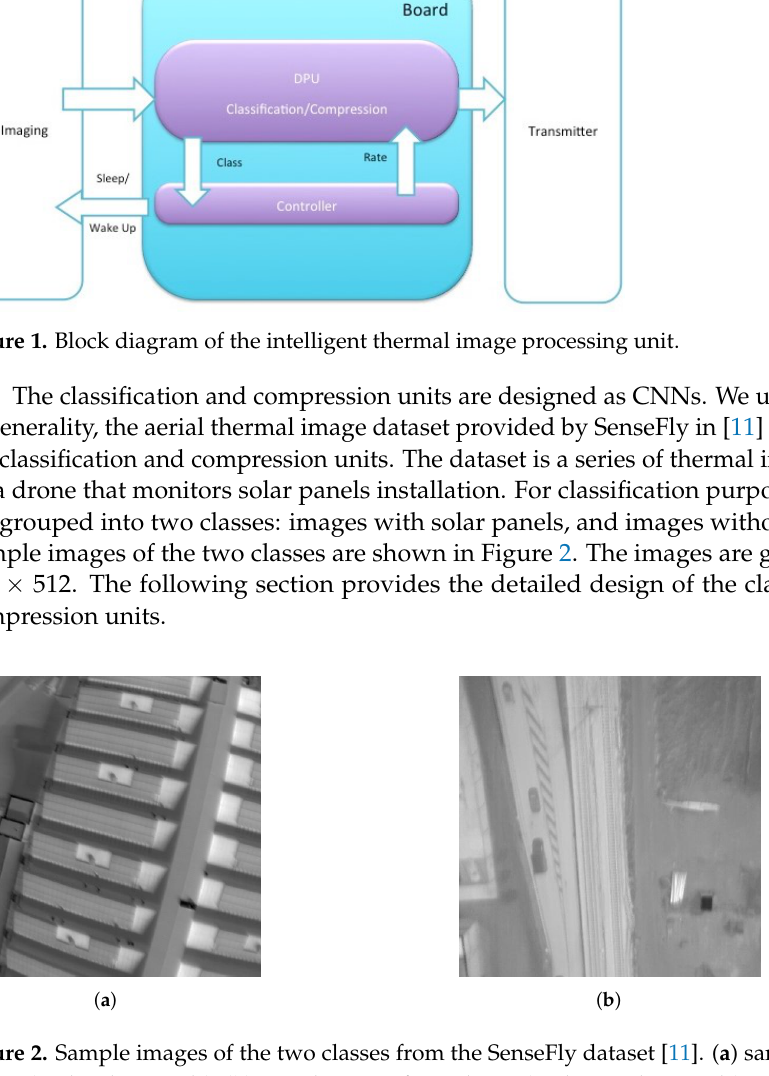
Figure 2. Sample images of the two classes from the SenseFly dataset [11]. ( a ) sample image from class 1 (with solar panels); ( b ) sample image from class 2 (without solar